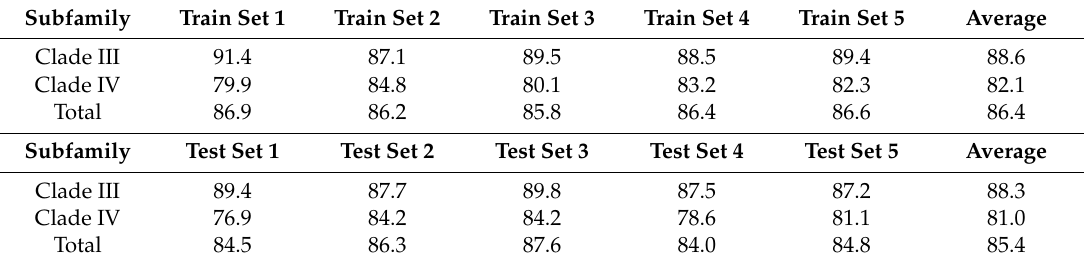
Table 3. Summary of results of training and test match (%) of clade III (Nep) and clade IV (Aju + Lam +